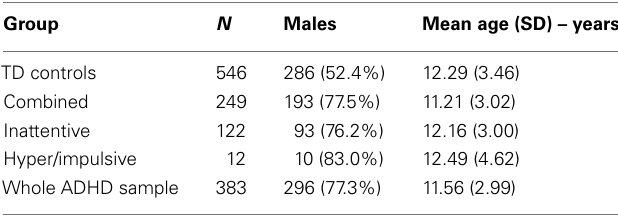
Table 1 | Demographic information of the subjects from theADHD-200